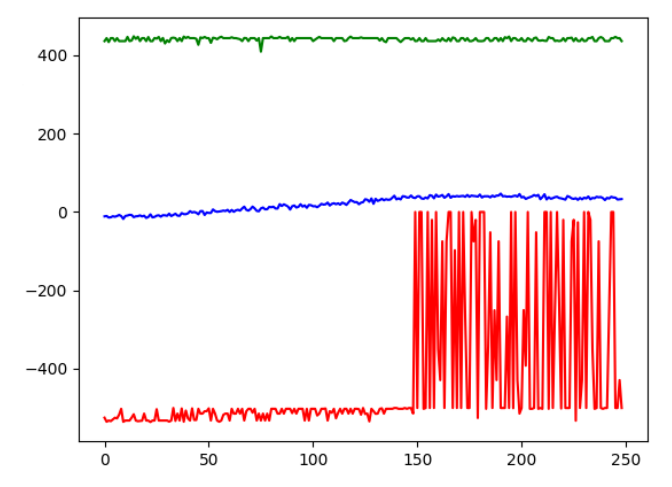
Figure 5. The learning dynamics of our real-world LSTM example.